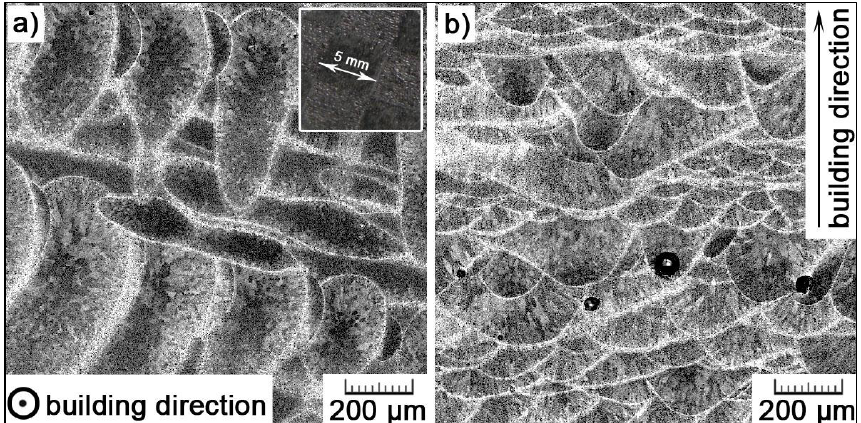
Figure 2. Macrostructure of the SLM AlSi 9 Cu 3 Fe alloy in ( a ) transversal and ( b ) longitudinal section (image inserted in ( a ) represents a macroscopic view of the chessboard scanning